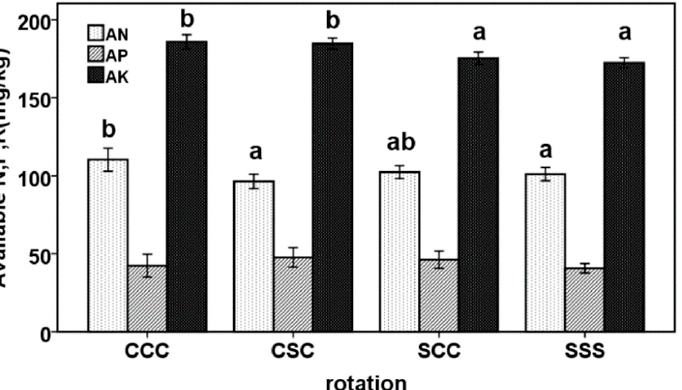
Figure 6. The effects of crop rotations on the total soil available N (AN), P (AP), and K (AK) content. Error bars represent standard deviations ( n = 3). Different letters show significant differences among the treatments ( p < 0.05).